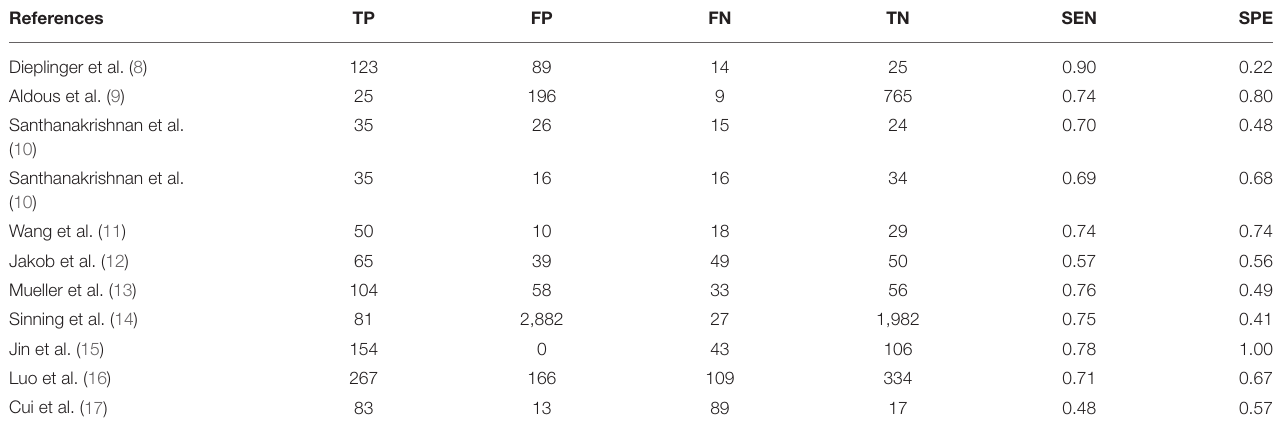
TABLE 2 | Main findings of the included